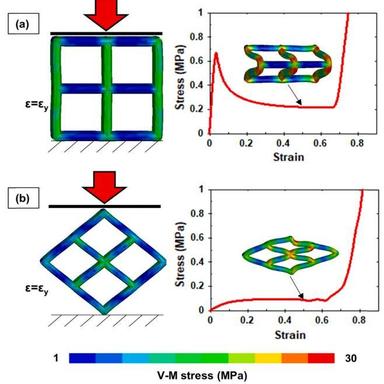
Mechanical responses of the cubic lattice when the load is applied in different directions with respect to the struts of the cell. a) Stretch-dominated behaviour, and b) bending-dominated behaviour.